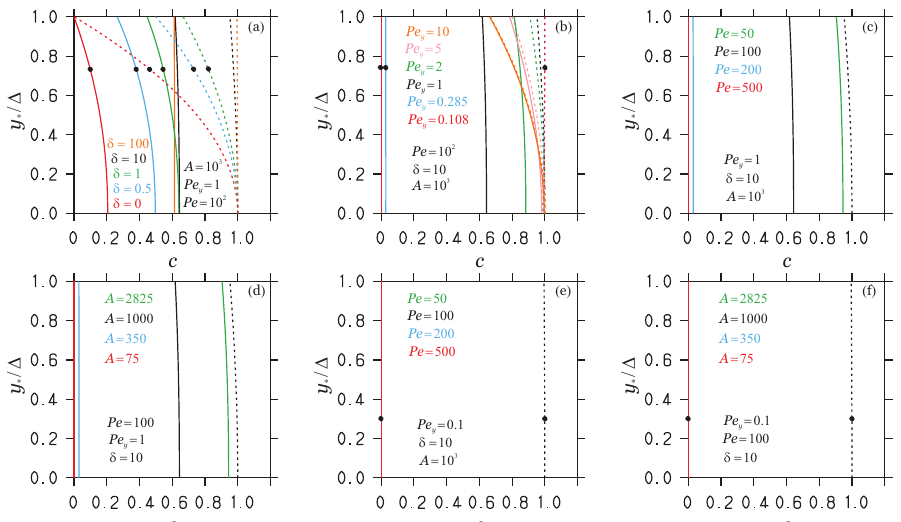
Figure 6. The concentration distribution along y ∗ from y 1 ∗ (lower bound) to y 2 ∗ (upper bound) at x ∗ = 0 (dashed lines) and x ∗ = x 2 ∗ (solid lines). Reference values δ = 10, Pe y = 1, Pe = 10 2 , and A = 10 3 are considered in ( a – d ) in conjunction with variations of δ , Pe y , Pe , A . In ( e , f ), complementary cases to ( c , d ) are considered to cover the p > 0 case, where Pe y = 0.1 in contrast to Pe y = 1 in ( c , d ). The reference parameters kept constant are also given. The black dots on curves indicate p > 0 cases. The x ∗ = 0 profiles are unaffected by Pe , A variations. In ( e , f ), all solid curves coincide.